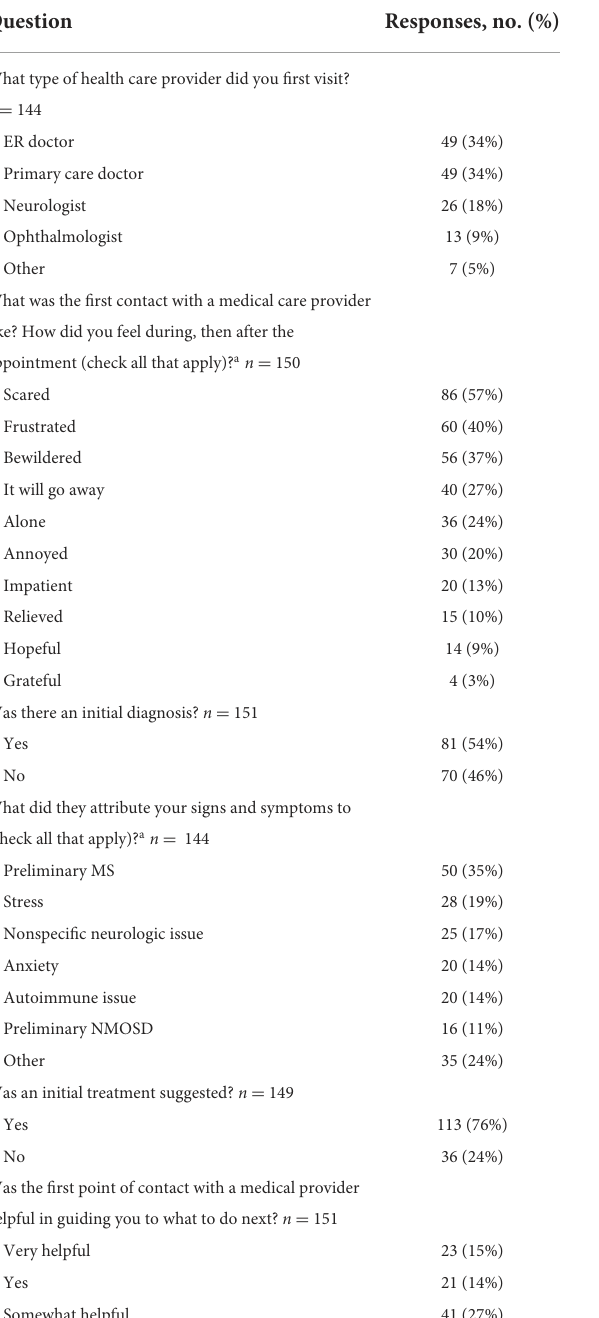
TABLE 2 Patient first interaction with a health care provider. Question